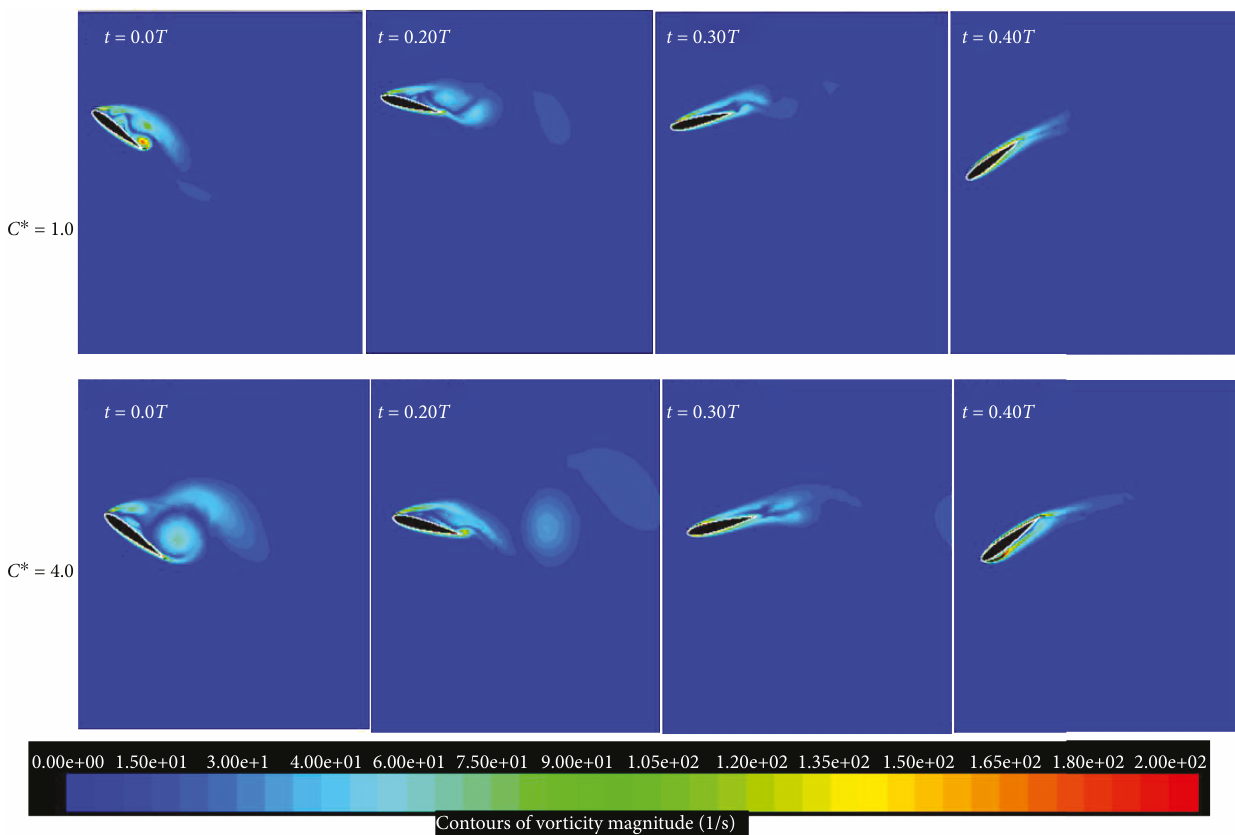
Figure 13: The vorticity contours of the considered cases with C ∗ = 1 0 and 4.0, K ∗ = 1 0